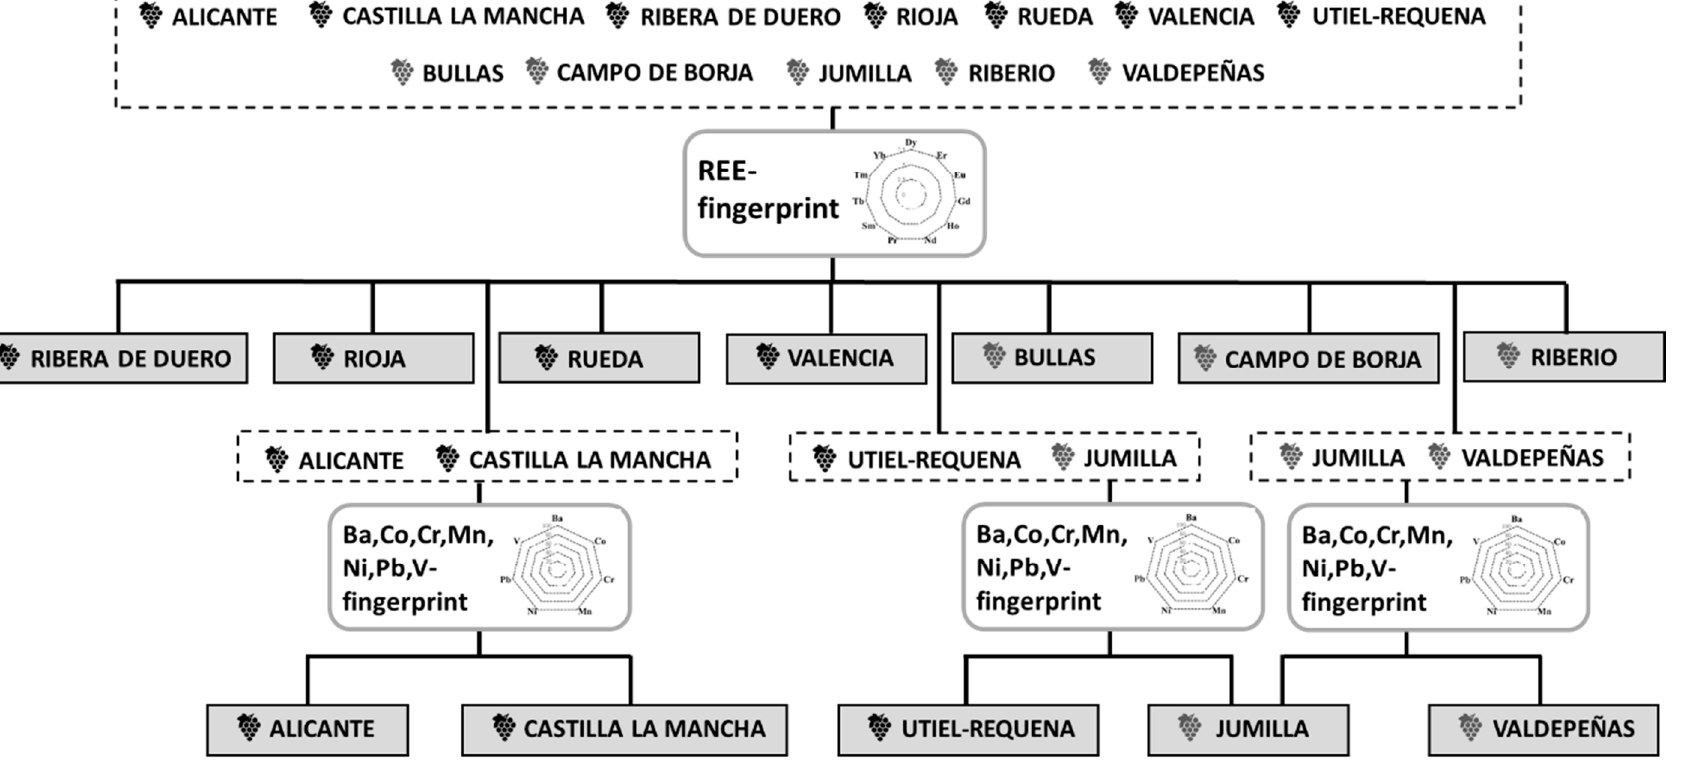
Figure 5. Scheme of separation of the different protected designation of origin (PDOs) based on the REEs (Dy, Er, Eu, Gd, Ho, Nd, Pr, Sm, Tb, Tm and Yb) and the alternative metals (Ba, Co, Cr, Mn, Ni, Pb and V) fingerprints.